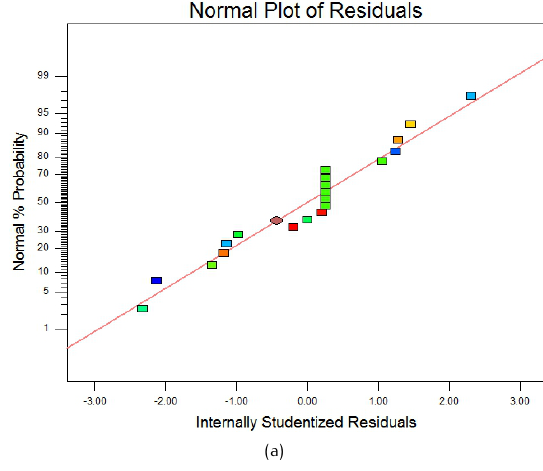
tigate the effects of the three independent variables on the response functions. The independent variables were Initial concentration of dye (A), concentration of sucrose (B), and concentration of ammonium nitrate (C). The low, center and high levels of each variable are designated as –1, 0, and +1, respectively as illustrated in Table 2. These experimental levels for each variable were selected based on the literature values, available resources and results from preliminary